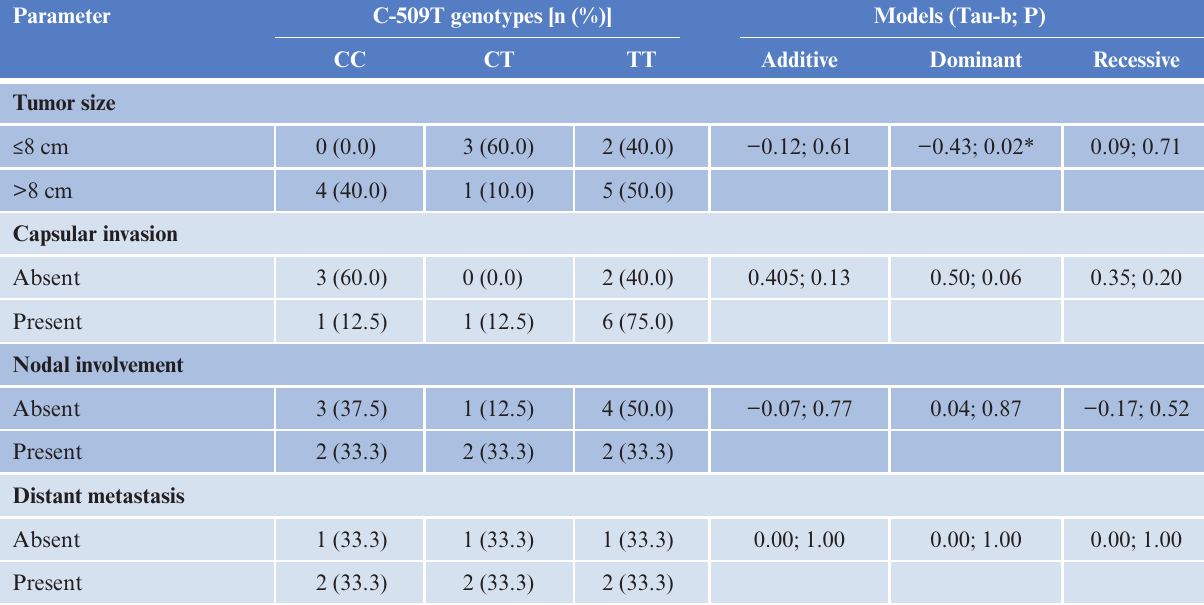
Table 3: Correlation analyses between TGFB1 rs1800469 and WT patient’s clinicopathological features.